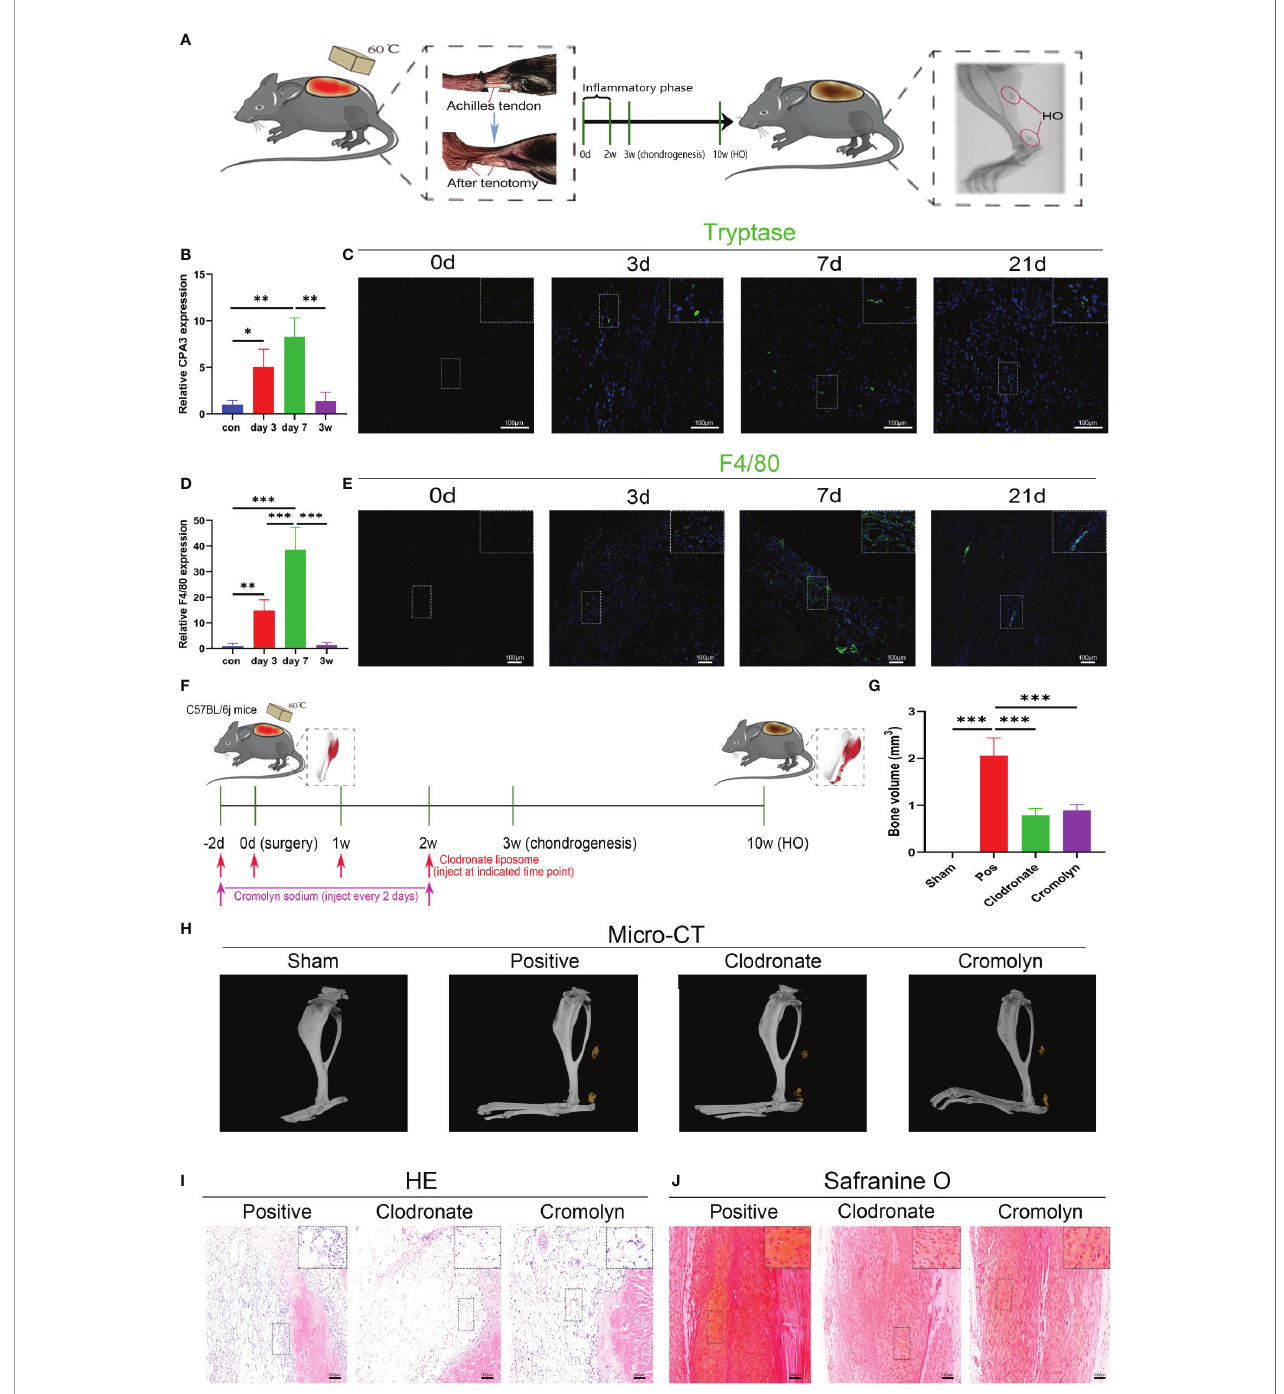
FIGURE 1 | Both macrophages and mast cells are critical participants in trauma-induced heterotopic ossi fi cation (HO). (A) Schematic depiction of the establishment of a murine burn/tenotomy model and different stages of HO progression. (B, D) Relative gene expression of the mast cell marker CPA3 and macrophage marker F4/80 as evaluated by qRT-PCR. (C, E) Immuno fl uorescence staining of the mast cell marker tryptase and macrophage marker F4/80 at the indicated times. (F) Schematic depiction of macrophage depletion and mast cell stabilization protocols for animal experiments. (G, H) Micro-CT scanning for observation and quanti fi cation of HO formation. (I) HE staining of the tissue section 3 days after burn/tenotomy. (J) Safranine O staining of the tissue section 3 weeks after burn/ tenotomy. Original magni fi cation is 40x for tryptase fl uorescence staining and 20x for other staining. Inserts are approximately 3.5x magni fi ed images of the boxed area. N=4/group, *P < 0.05, **P < 0.01, ***P <